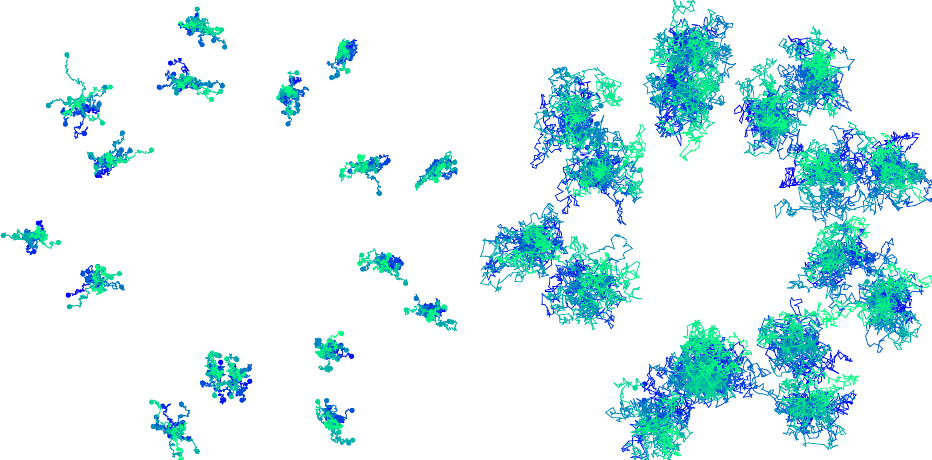
Figure 5. ( left ) One configuration of 17 landmarks overlayed the MR image from which the config- uration was annotated. ( right ) All 14 landmark configurations plotted together (one color for each configuration of 17 landmarks).